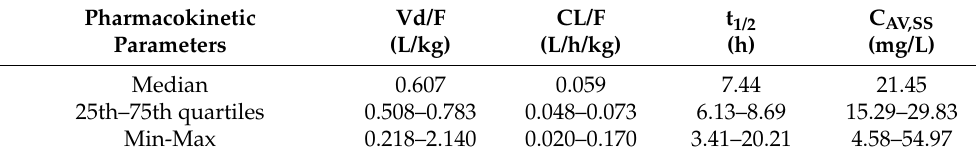
Table 2. Pharmacokinetic parameters of levetiracetam observed in the study population.